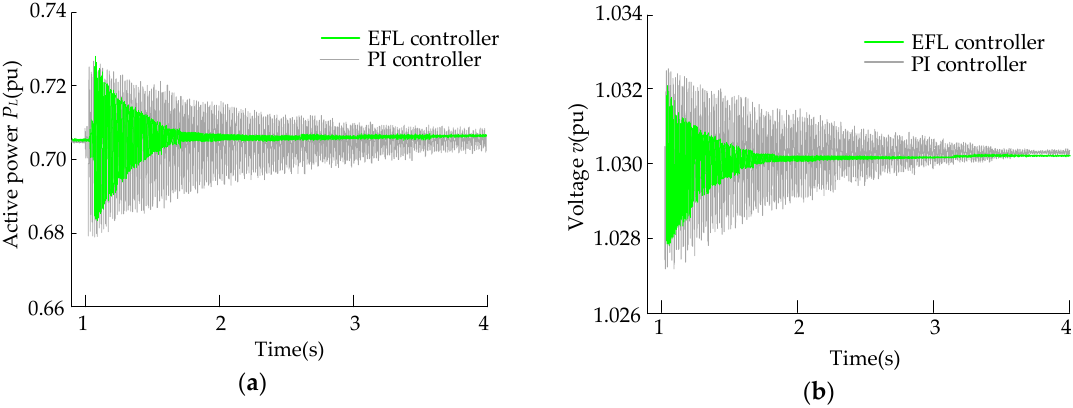
Figure 7. DC-link voltage ( v dc ) at a wind speed of 8 m/s and a series-compensation of 70%.